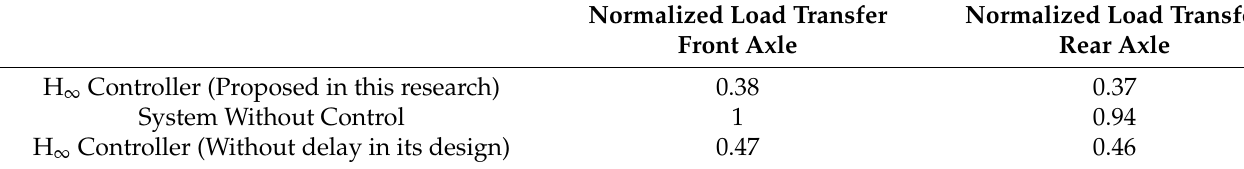
Table 7. Normalized Load Transfer for test 3.